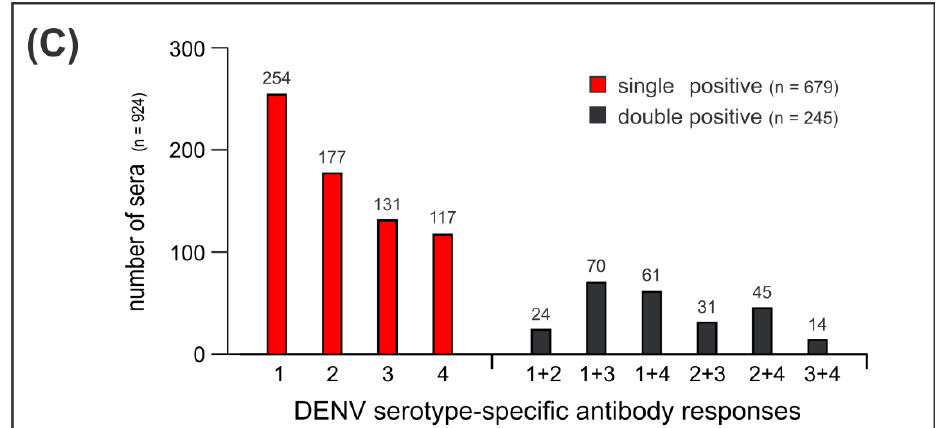
Figure 5. Results of the ED3 dot assay. Reactivity of sera to the DENV-1-4 antigens, ED3, ED3s and mED3. Red bars indicate sera with single-dot reactivity to only one of the four DENV antigens within the respective antigen panel; black bars indicate double-reacting serum samples. ( A ) Number of sera reactive to each set of DENV-1-4 antigens. x axis: 0 = not reactive, 1 = single dot positive, 2 = double dot positive, 3 = triple dot positive, 4 = quadruple dot positive; y axis: number of sera. ( B ) Number of sera ( n = 1099) with single, double, triple and quadruple reactivity tested by the ED3 dot assay. X axis: 0 = not reactive, 1 = single dot positive, 2 = double dot positive, 3 = triple dot positive, 4 = quadruple dot positive; y axis: number of sera. ( C ) Total results of the ED3 dot assay related to DENV-1-4.